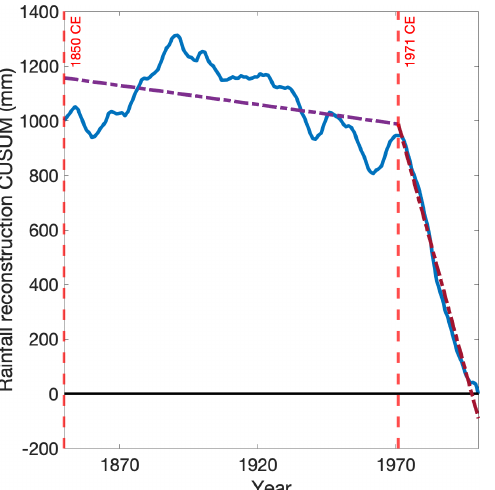
Figure 5. CUSUM time series on rainfall reconstruction for the period from 1850 to 2000CE. The yellow dotted lines are each in- terval’s gradient calculated using BREAKFIT analysis, with 1971 CE identified as the break point. The gradient before 1971CE is − 1.40mmyr − 1 ; the gradient after 1971CE is − 37.16mmyr − 1 .